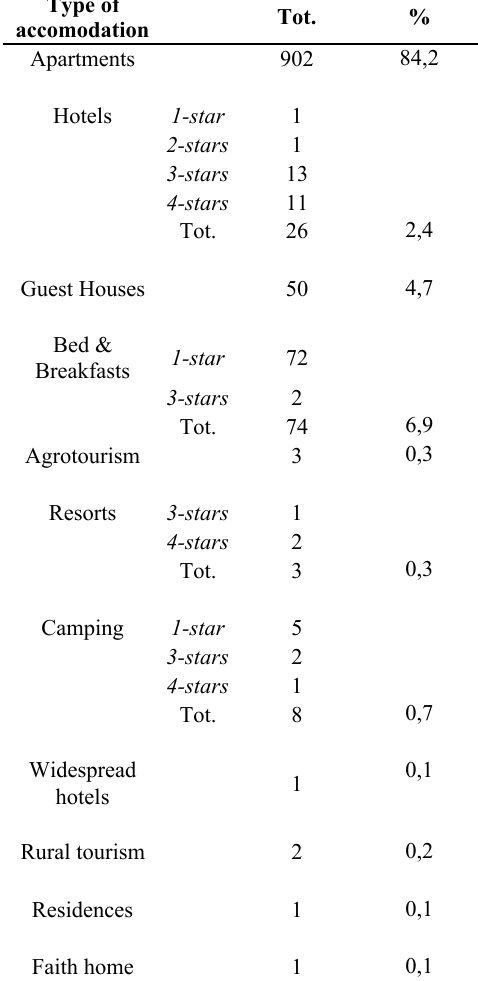
Table 1. Accommodations in Castellabate. Source: authors’ elaboration from municipality data Type of Tot. % accomodation